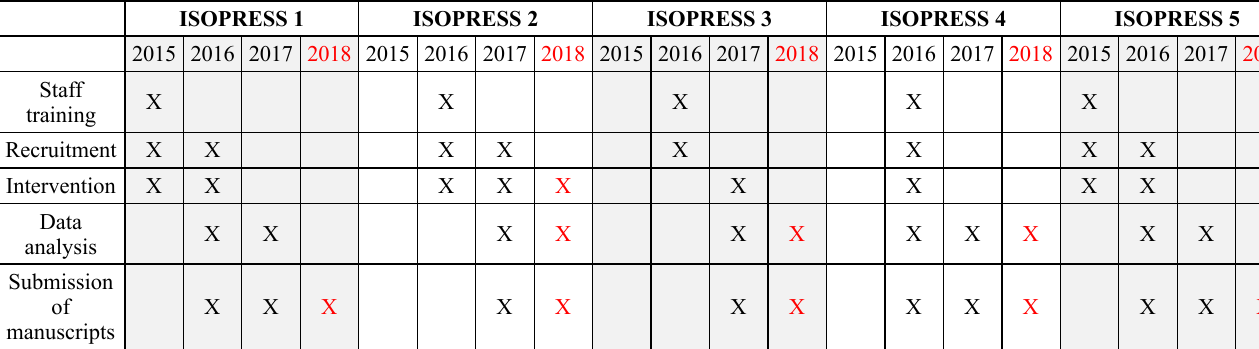
Table 4. Schedule of each study of ISOPRESS